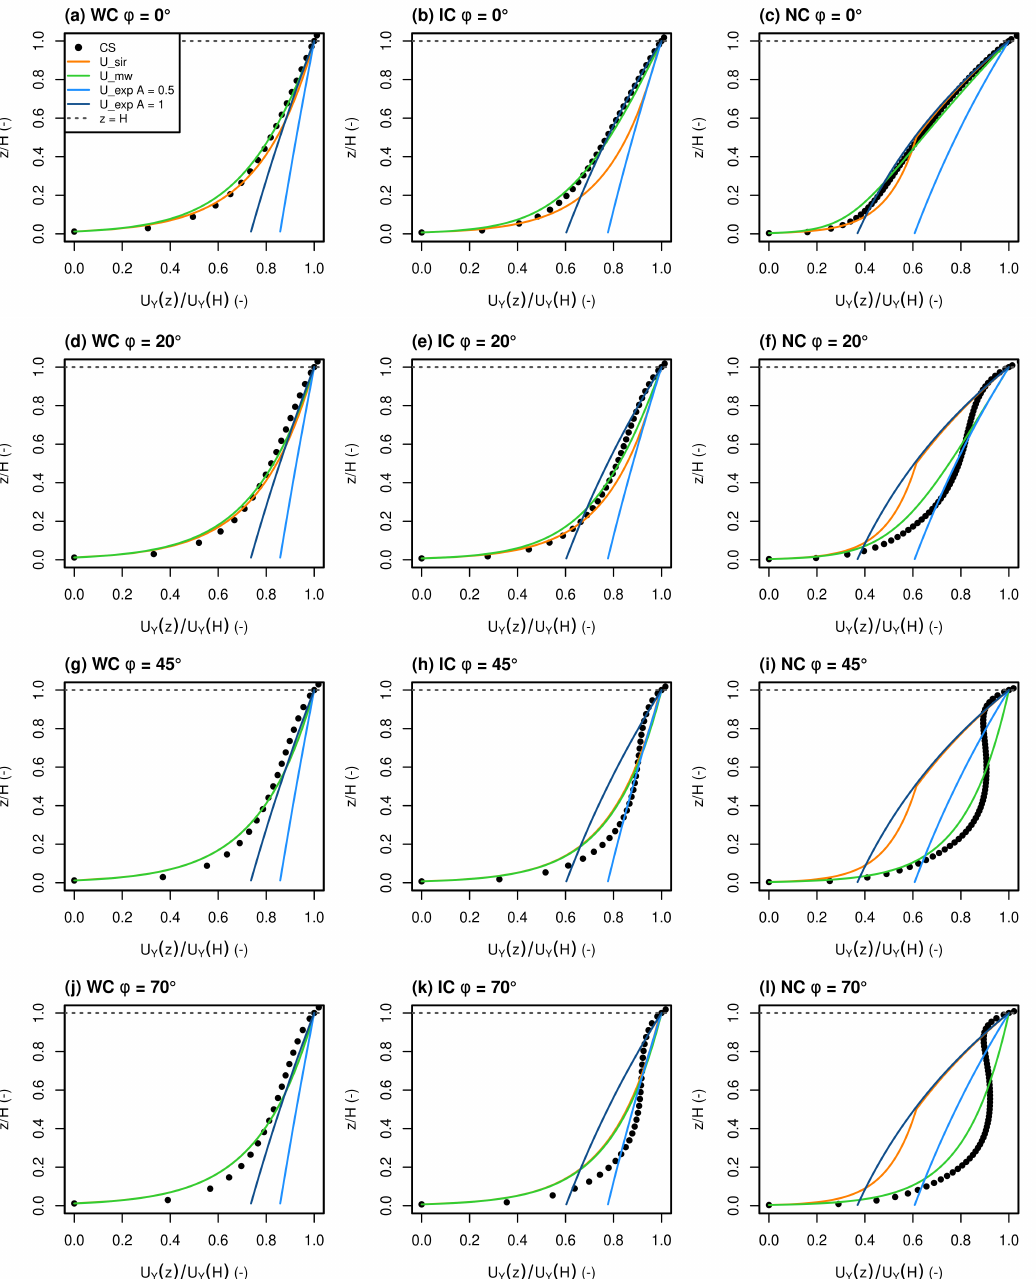
Figure 6. Comparison of U Y ( z ) normalized by U H , ϕ between Code_Saturne and the different MU- NICH parametrizations for ( a , d , g , j ) WC, ( b , e , h , k ) IC, ( c , f , i , l ) NC and for ( a – c ) ϕ = 0 ◦ , ( d – f ) ϕ = 20 ◦ , ( g – i ) ϕ = 45 ◦ and ( j , k , l ) ϕ = 70 ◦